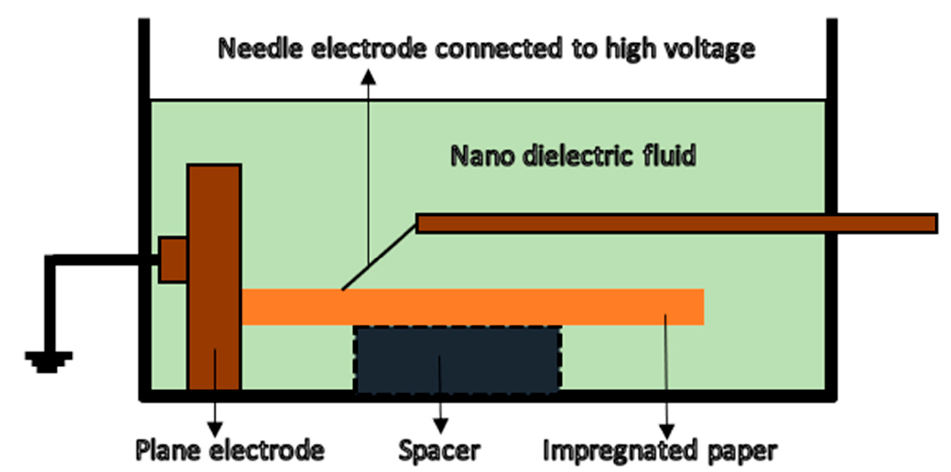
Figure 7. Set up for creeping flashover voltage test.